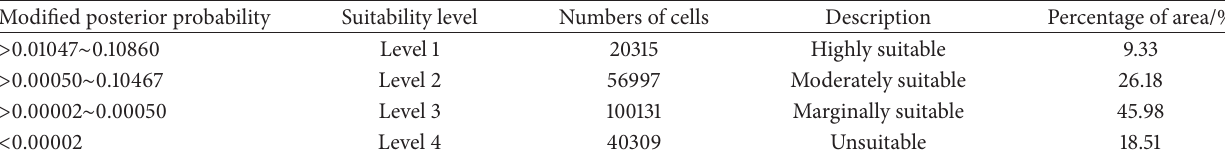
Table 2: Classification of land use suitability in low-slope hilly regions in